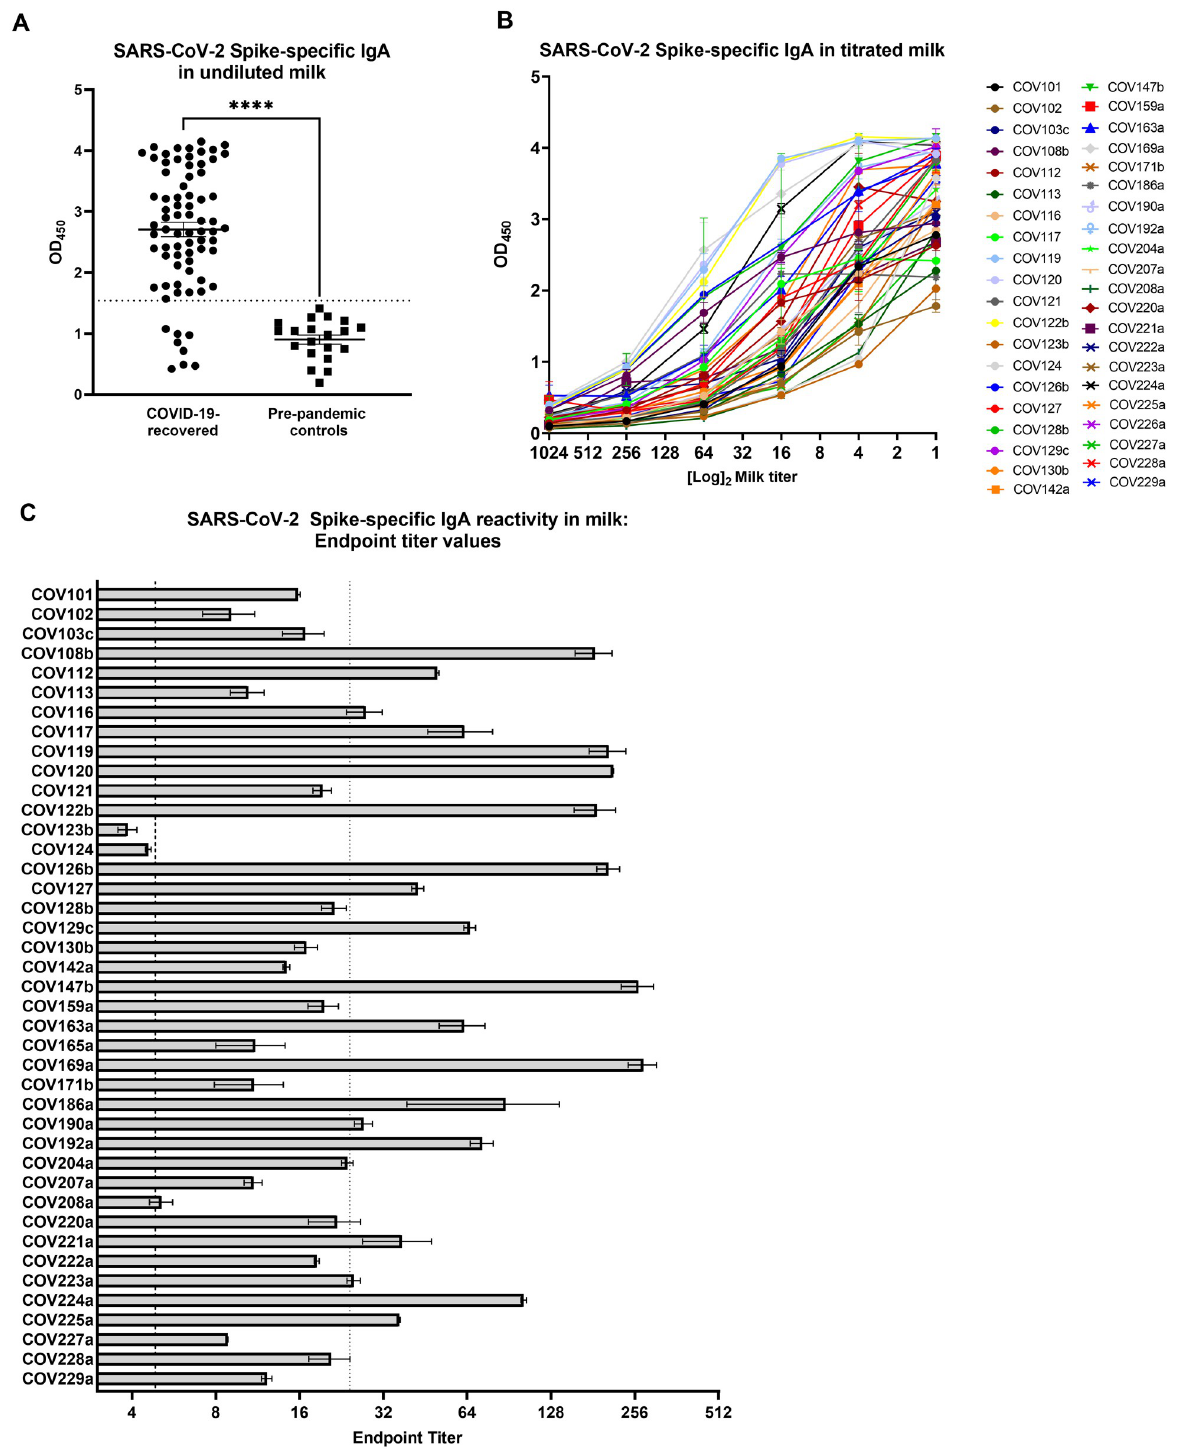
Fig 1. A robust, Spike-specific IgA response in milk commonly occurs after SARS-CoV-2 infection. (A) Screening of undiluted milk samples for specific IgA by ELISA against the full-length Spike trimer. COVID-19 group, N = 74; control group N = 20. Mean values with SEM are shown. Dotted line: positive cutoff value (mean OD of negative control milk samples + 2 � SD). ���� p < 0.0001. Mann-Whitney U test (2-tailed) was used to compare grouped data with significance level set at p < 0.05. (B) Full titration against Spike of 40 milk samples found to be positive by the initial screening. (C) Endpoint dilution titers of the 40 titrated milk samples. Segmented line: positive cutoff value; dotted line: 5x positive endpoint cutoff value, designating samples as ‘high-titer’. Mean values with SEM are shown.